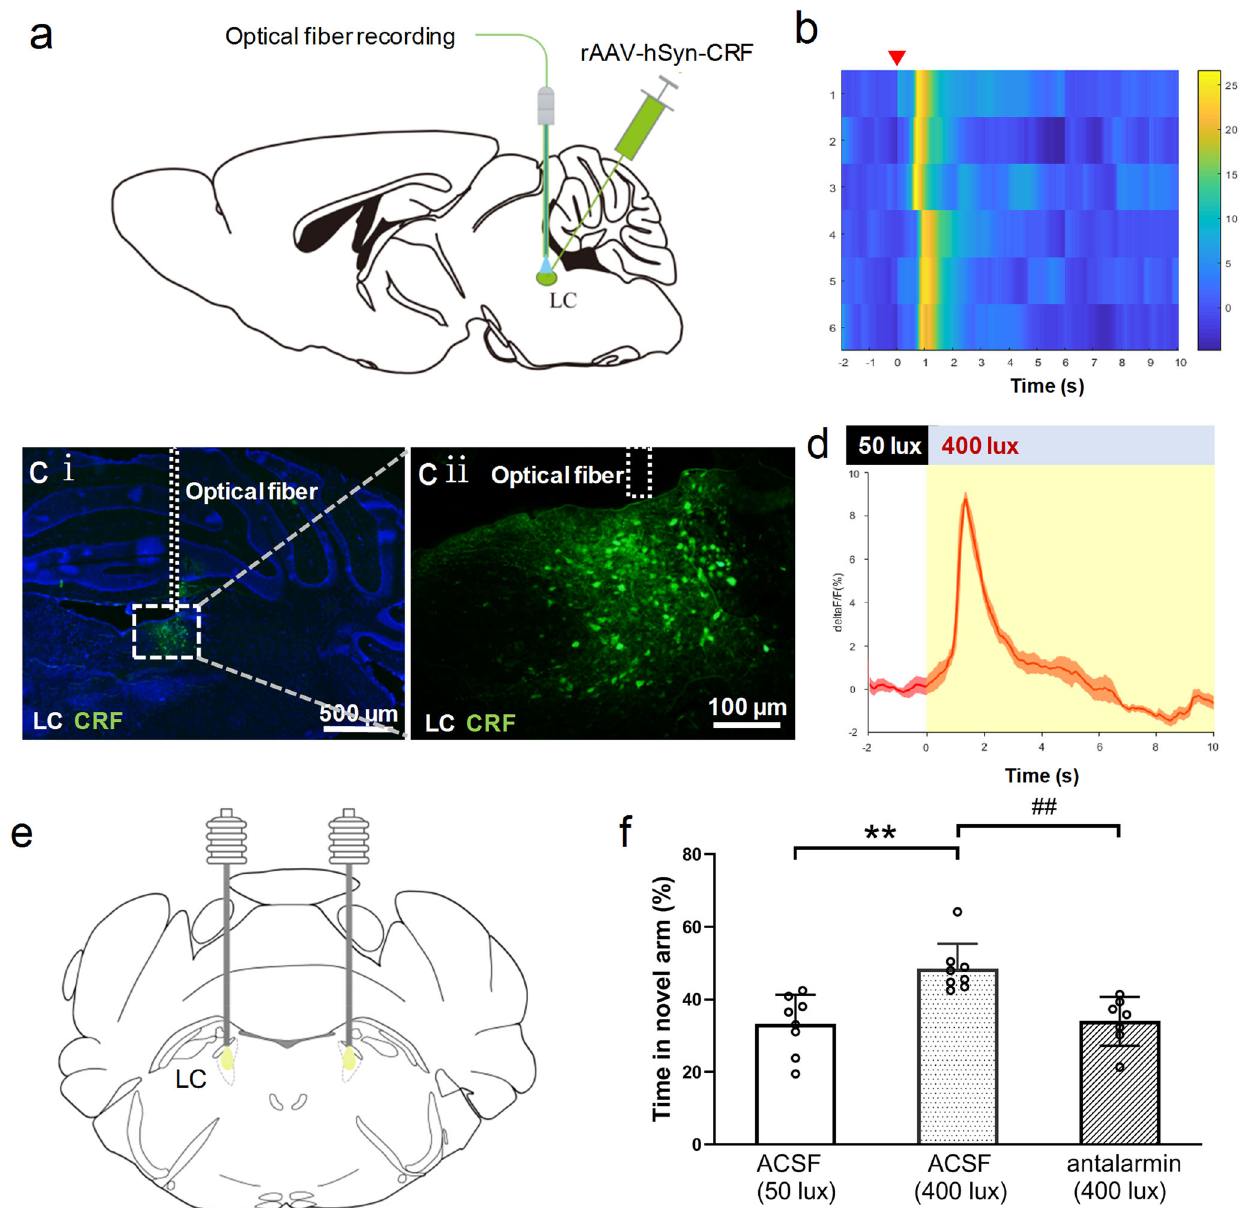
Fig. 6 CRF was released from CeA-LC projection neurons and activated LC neurons to promote spatial memory retrieval. a Schematic illustration of intra-LC injection of the AAV-hSyn-CRF virus, and the implantation of optical fi bers above the injection site. b The heat map of CRF signals in the LC after 400 lux light exposure in six mice. c (i) c (ii) Intra-LC injection of the AAV-hSyn-CRF virus-induced restricted expression of CRF in the LC. The dotted lines represent the embedded optical fi ber. d The averaged CRF signal induced by 400 lux light exposure ( n = 6). e The schematic diagram of bilateral cannula implantations in the LC. f Quanti fi cation of time spent in the novel arm in the Y-maze test. ACSF (50 lux): 50 lux light exposure was adopted both during the training and testing periods, and ACSF was infused into the LC 10 min before the testing period; ACSF (400 lux): 50 lux light exposure was adopted during the training period and 400lux light was used during testing, and ACSF was infused into the LC 10 min before the testing period. Antalarmin (400 lux): 50 lux light exposure was adopted during the training period and 400 lux light was applied during testing. The CRFR1 antagonist antalarmin was infused into the LC 10 min before the testing period. Data are expressed as mean ± SD. ** P < 0.01, ## P < 0.01 vs. indicated group, non-parametric Kruskal- Wallis H Test, n = 7 –